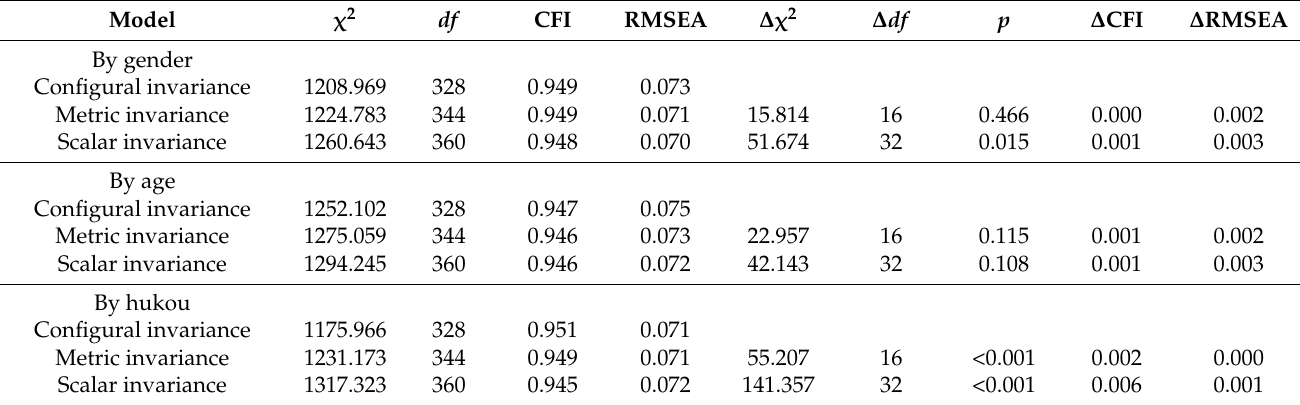
Table 3. Gender-, age-, and hukou-related measurement invariance of the GAS-C.